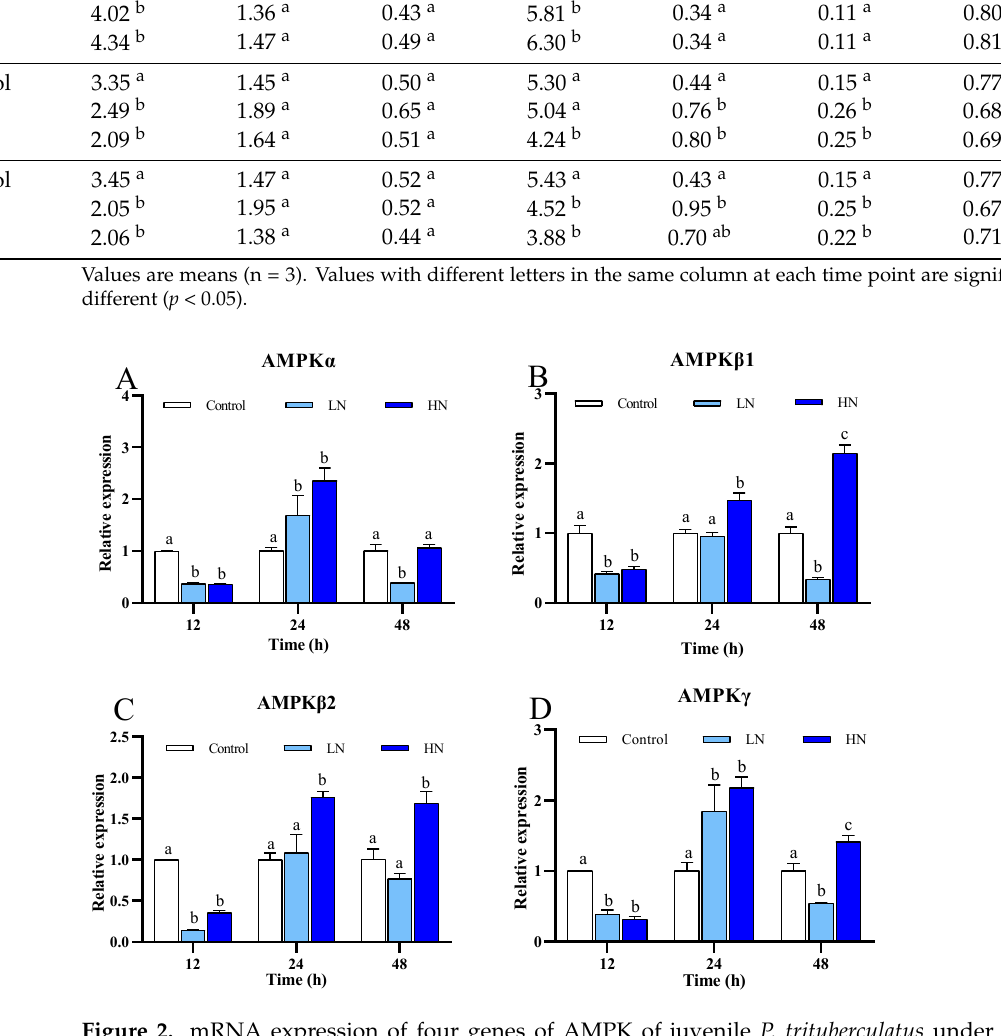
Table 2. Energy substance content in juvenile P. trituberculatus under nitrite stress. Values are means (n = 3). Values with di ff erent le tt ers in the same column at each time point are signi fi cantly di ff erent ( p < 0.05).